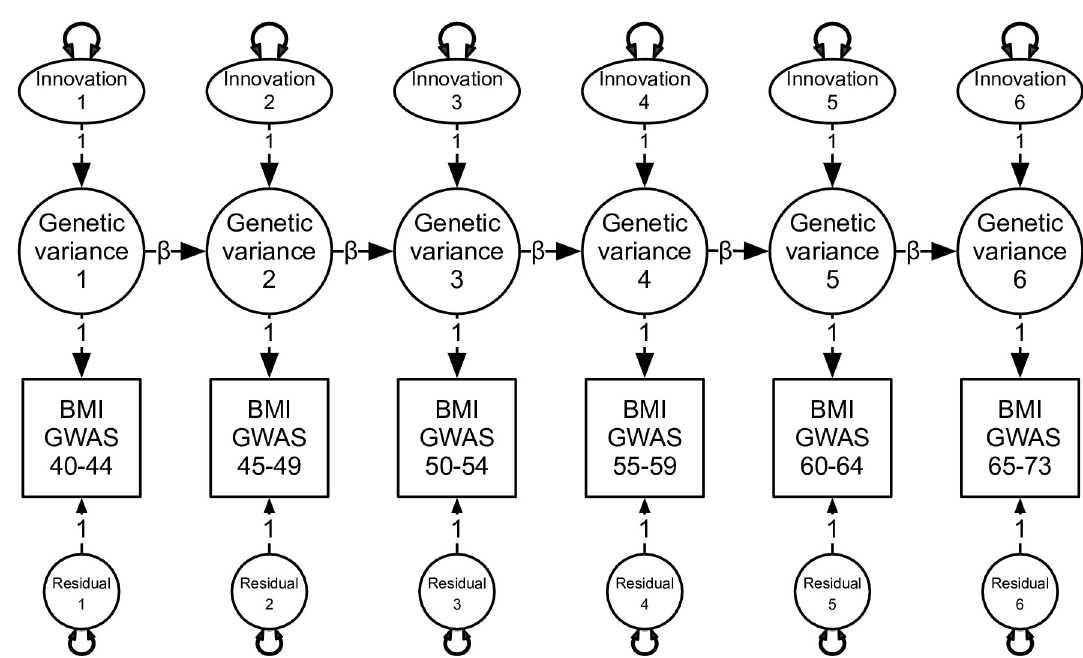
Fig 1. Autoregression model depicting genome-wide variation in BMI at each age interval. This development model predicts that genetic variation at each time interval can be decomposed into time-specific variation or ‘innovations’ & the causal contribution of genome-wide genetic variation from previous age intervals. Innovations refer to novel or age-specific genetic influences that are uncorrelated with previous genetic influences. This model also includes residual genetic variation not otherwise explained by the autoregression process. Double-headed arrows denote variation associated with innovations & residuals at each age interval. Beta ( β ) denotes the causal contribution of genetic variance from one age interval to the next.